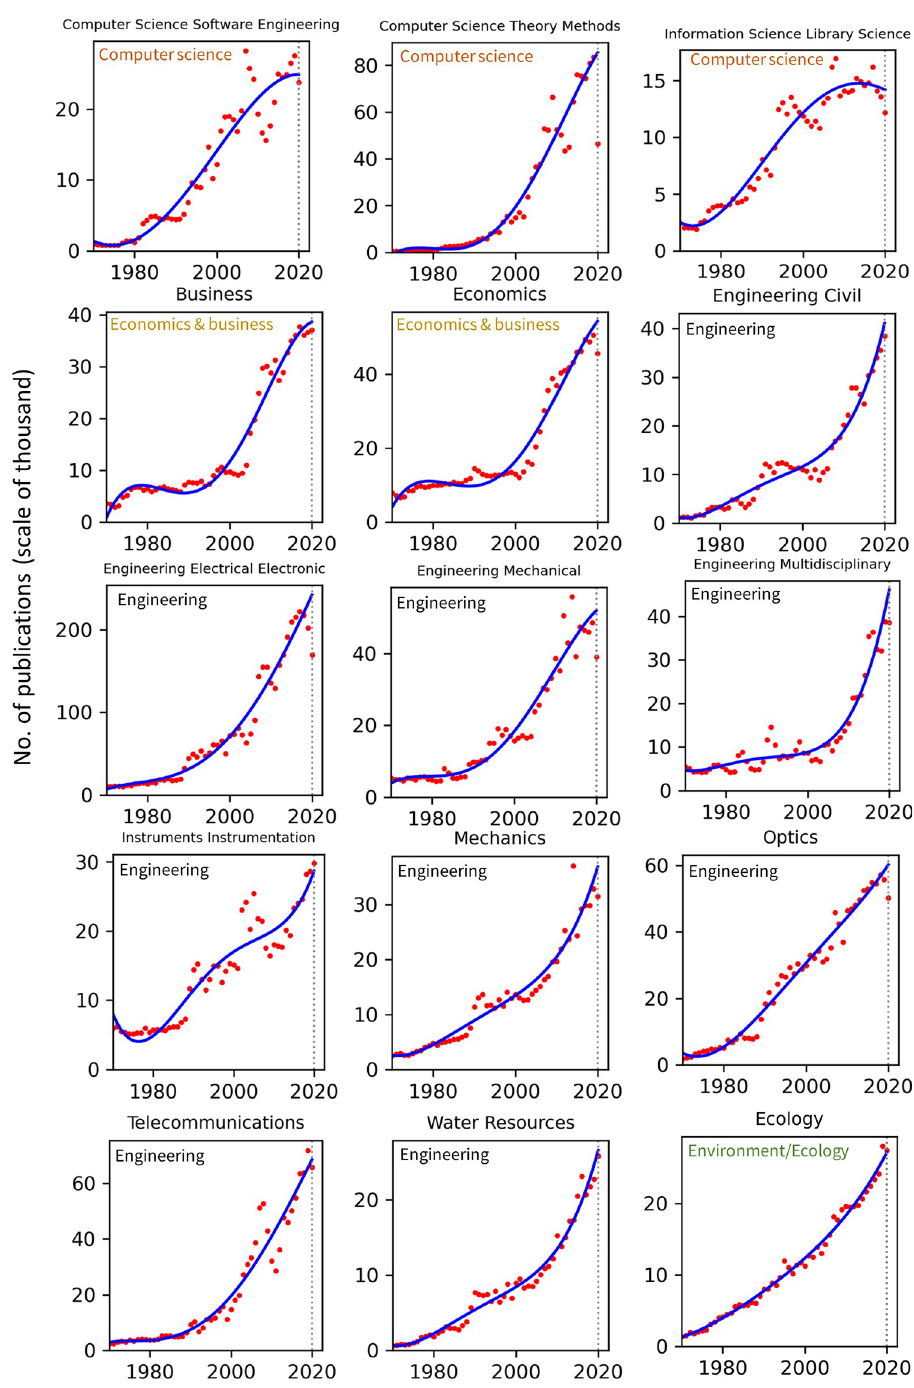
Fig 6. Temporal trends of research productivity in various scientific disciplines (part